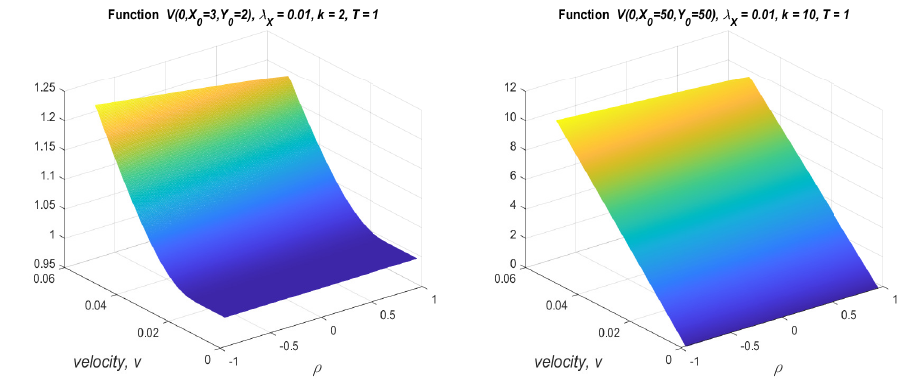
Figure 8. Dependence of value of the option V ( 0, X 0 , Y 0 ) according to Equation (37) on velocity v and ρ for X 0 = 3, Y 0 = 2 and k = 2 ( left ) and X 0 = 50, Y 0 = 50 and k = 10 ( right